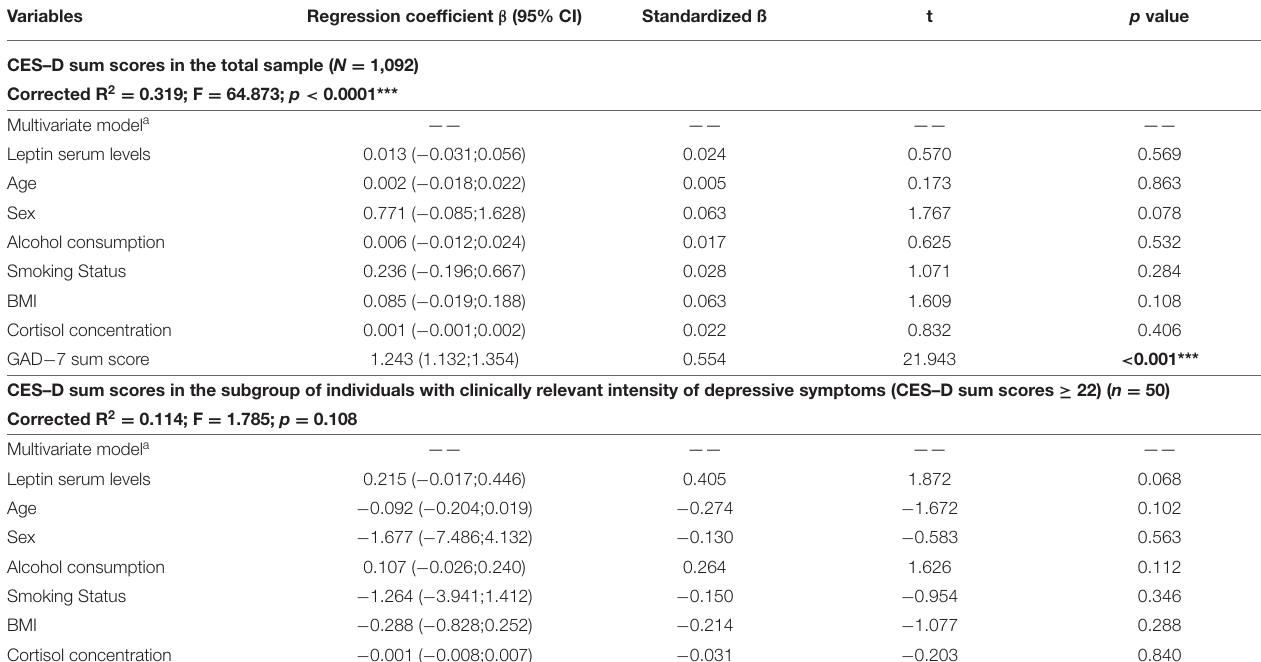
TABLE 4 | Results of multiple linear regression analyses regarding the association between leptin serum levels and CES-D sum scores reflecting the intensity of depressive symptoms in participants of the study.